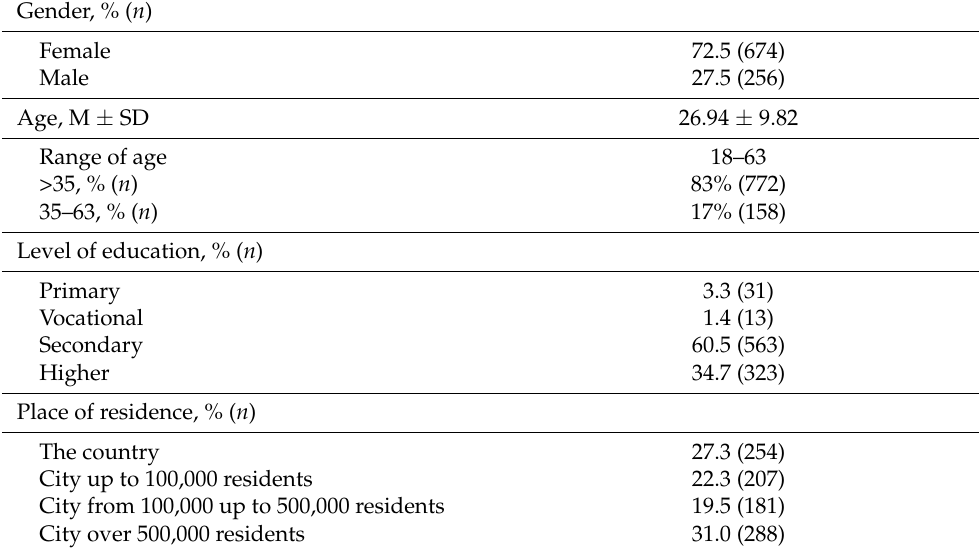
Table 2. Characteristic of participants ( N = 930).